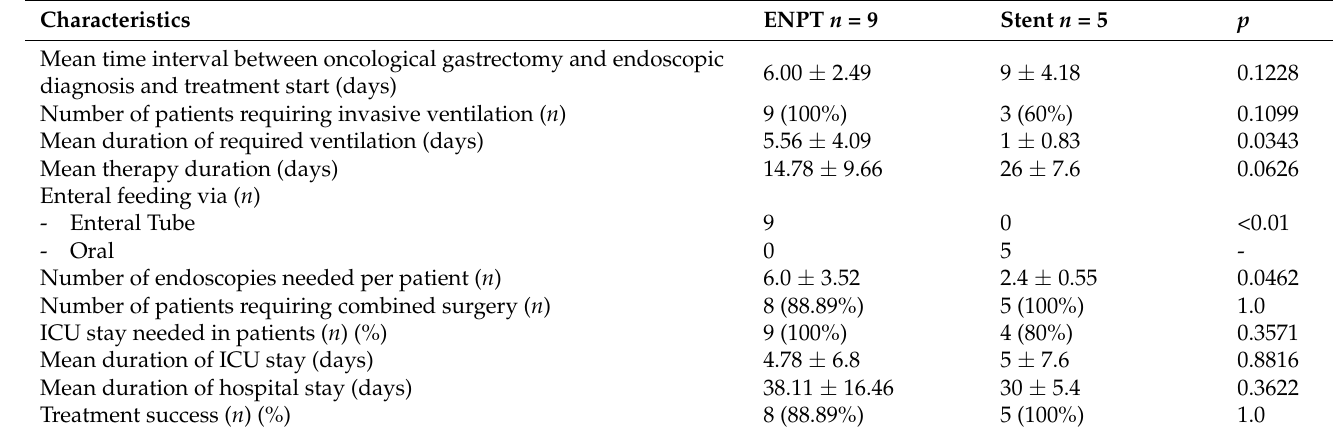
Table 2. Therapeutic